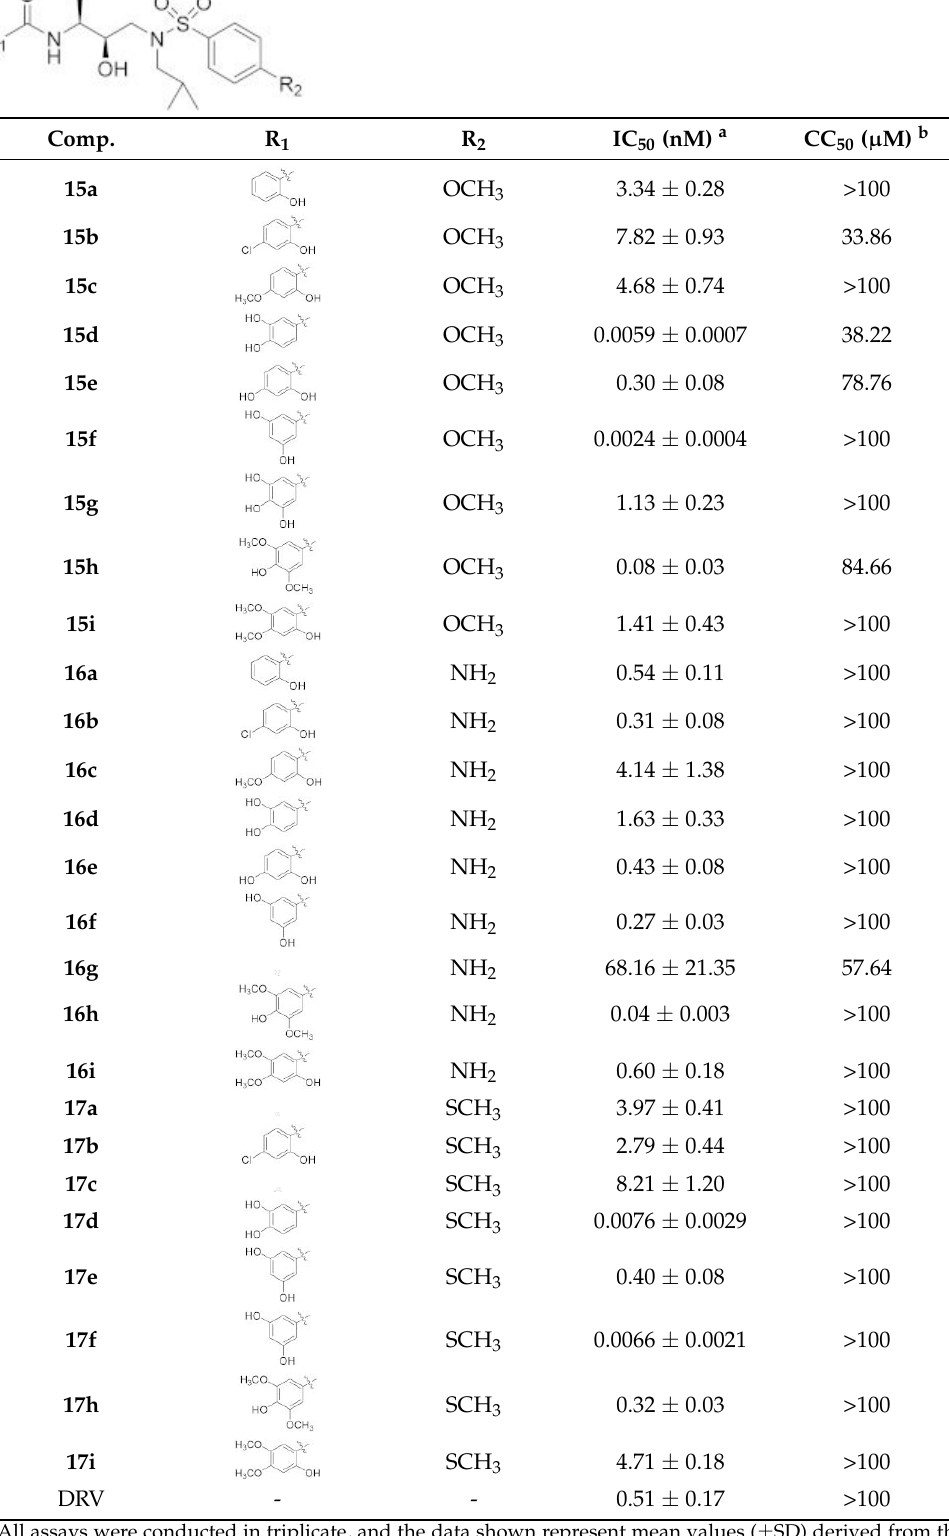
Table 1. HIV-1 protease inhibitory and antiviral activity, and cytotoxicity of inhibitors 15a − 17i .